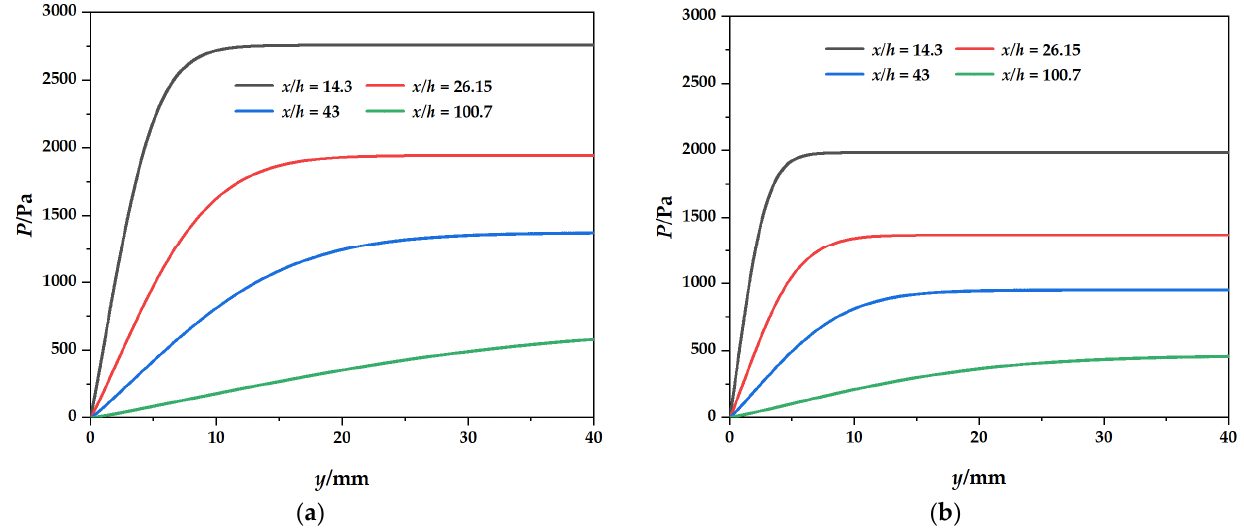
Figure 9. Pressure distribution with different x / h over logarithmic spiral wall surfaces at ( a ) x / R = 1 and ( b ) x / R = 2/3.